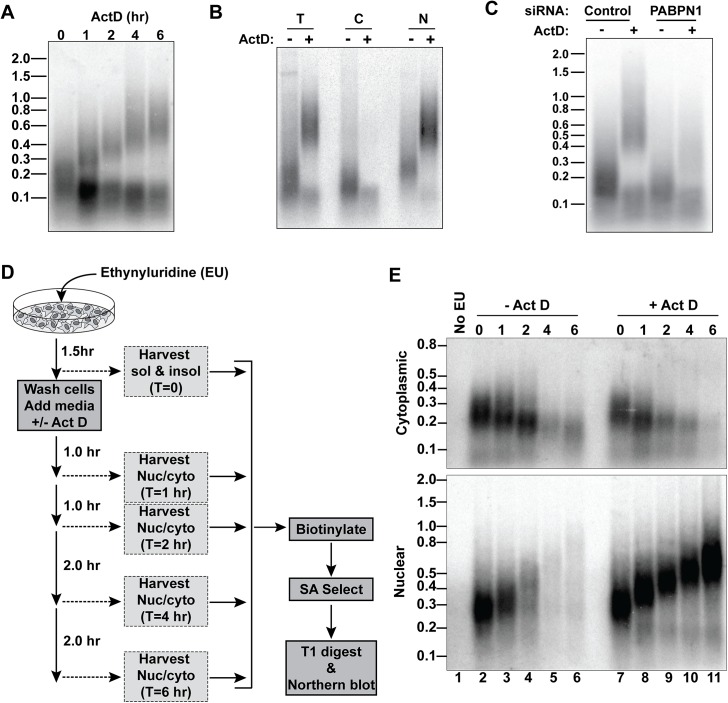
A large fraction of nuclear RNA is hyperadenylated upon ActD treatment.
(A) Total cellular poly(A) tails were examined by northern blot after ActD treatment. Mobility of molecular weight markers (kb) is shown. (B) Bulk poly(A) tails were examined from untreated or ActD treated cells from whole cells (T), cytoplasmic (C) or nuclear (N) fractions. (C) Northern blot for bulk poly(A) tails using RNA from cells treated with a control siRNA or siRNAs targeting PABPN1 +/-6-hr ActD treatment. (D) Scheme for metabolic labeling approach to examine bulk poly(A) tail dynamics. (E) Results of a metabolic labeling assay examining the bulk soluble and insoluble poly(A) tails in cells +/- ActD treatment. Lane 1 is a negative control from cells without EU treatment.